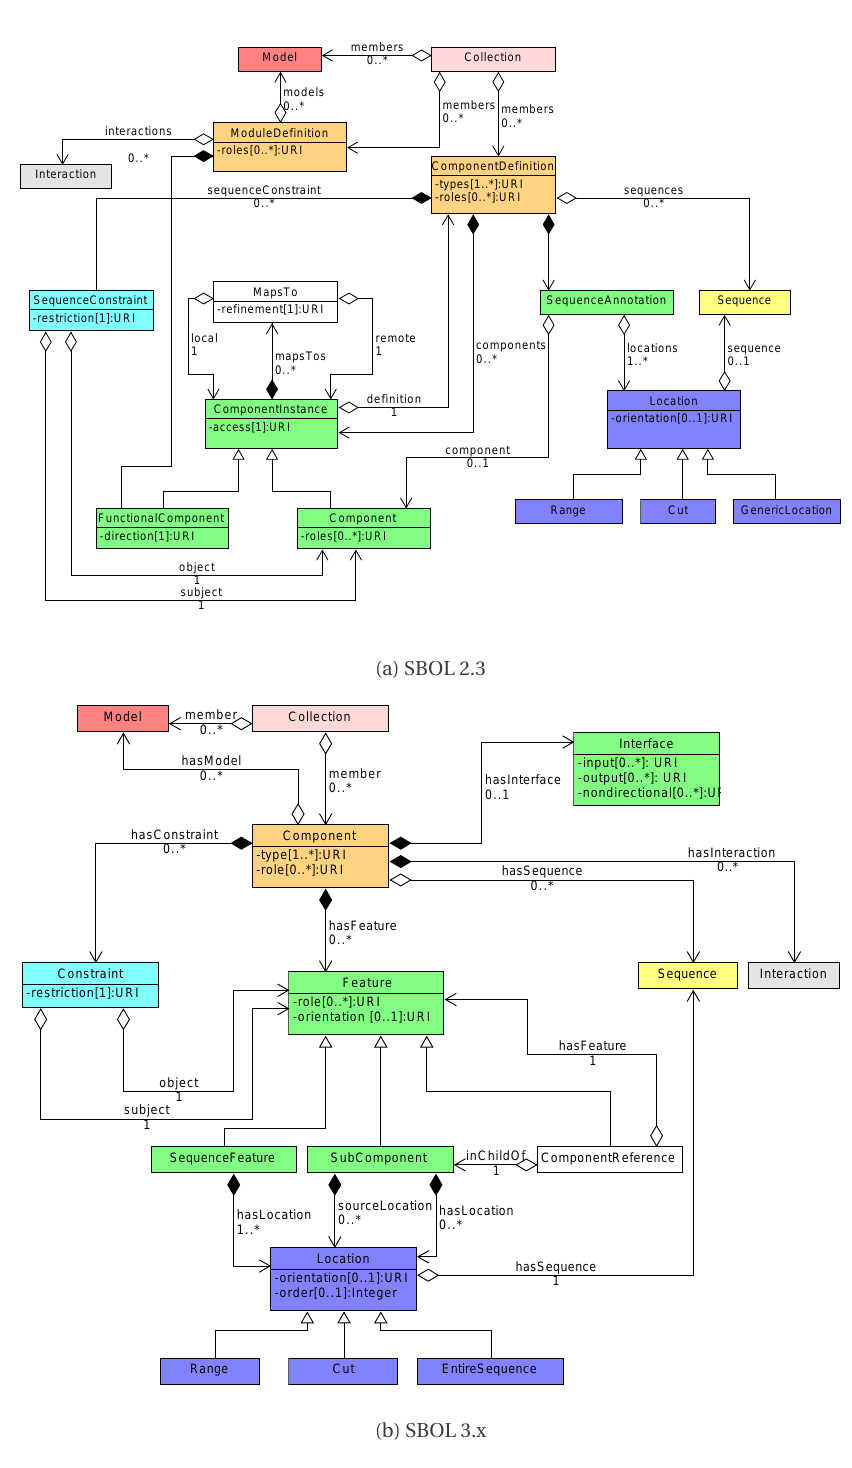
Figure 26: The mapping from the SBOL 2.3 data model to the SBOL 3.x data model, indicating corresponding classes/properties by